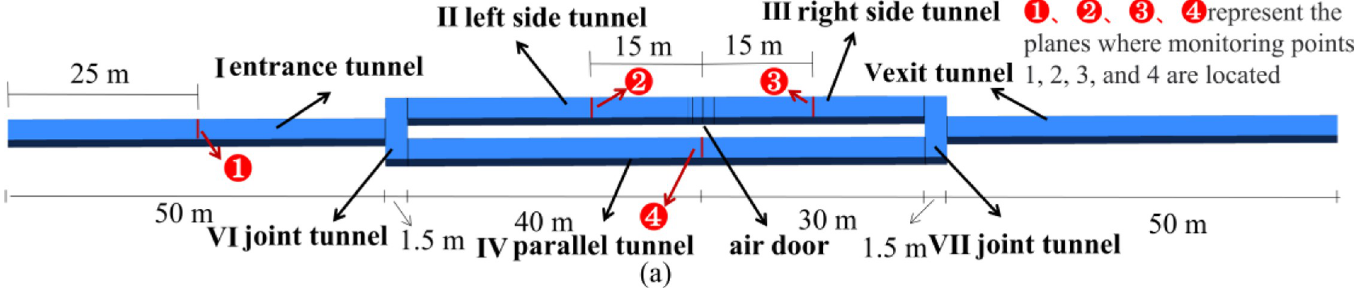
Fig 1. Overall tunnel dimensions and monitoring-point